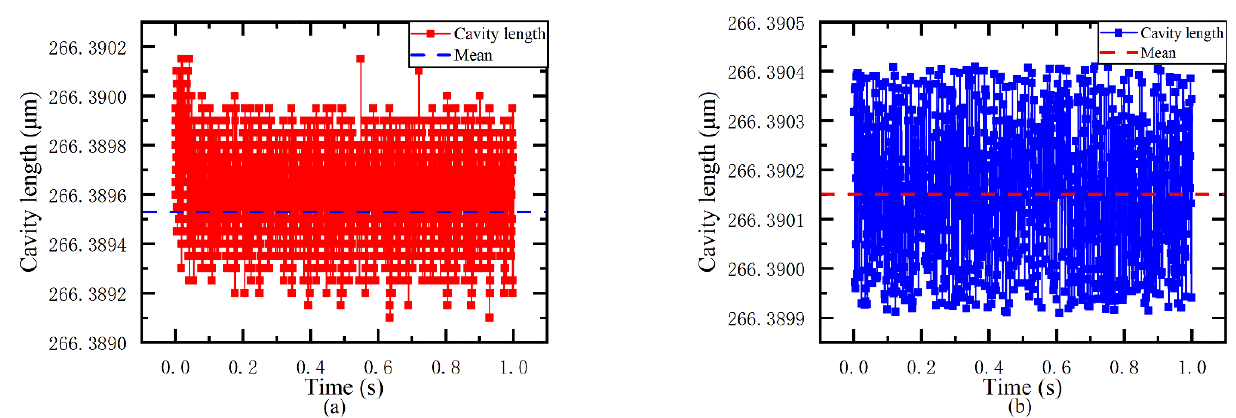
Figure 10. ( a ) Demodulation results of the demodulation system and ( b ) demodulation results of the spectrometer system.